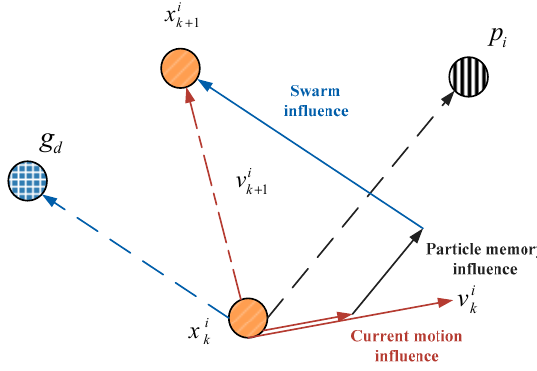
Figure 9. Illustration of the velocity and position updates in PSO.